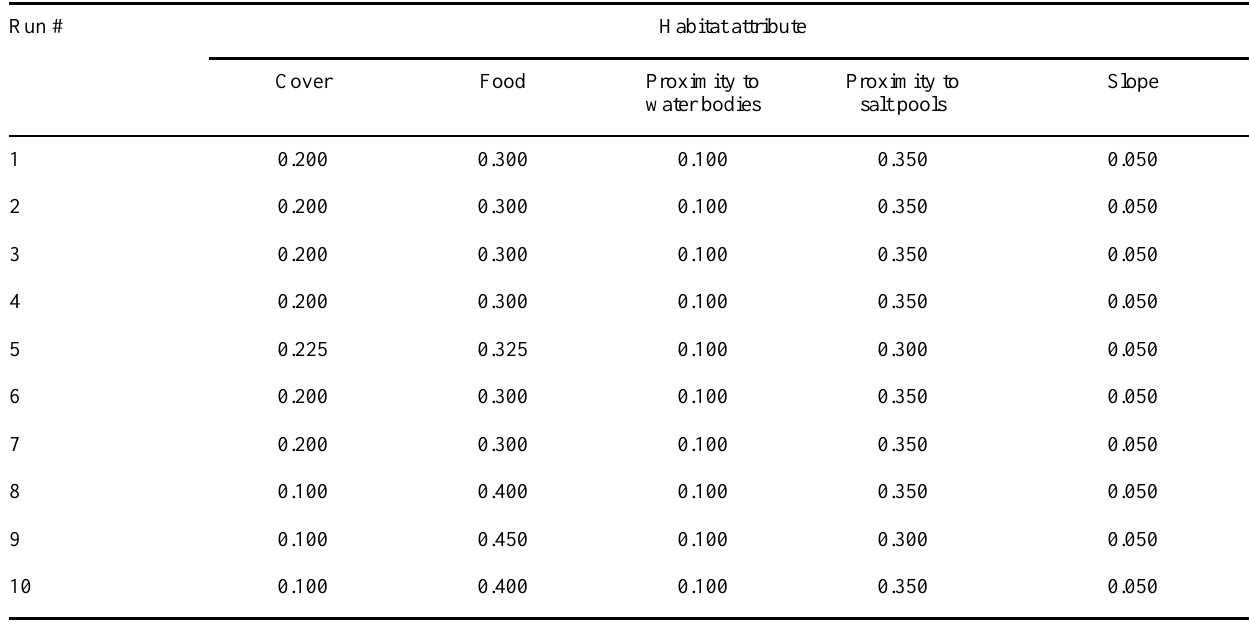
Table 4B. Habitat attribute weighting factors for the 10 calibration